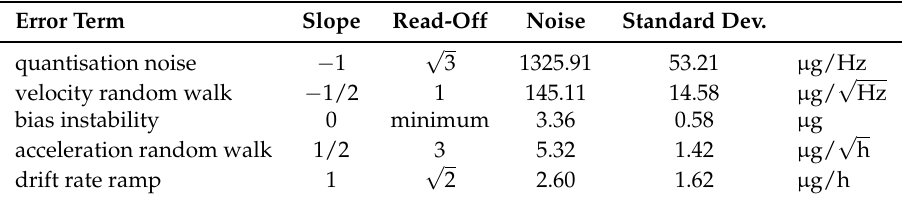
Table 2. Error coefficients identified from the Allan deviation curve in Figure 2. Units are in terms of the standard gravity value g = 9.80655 m/s 2